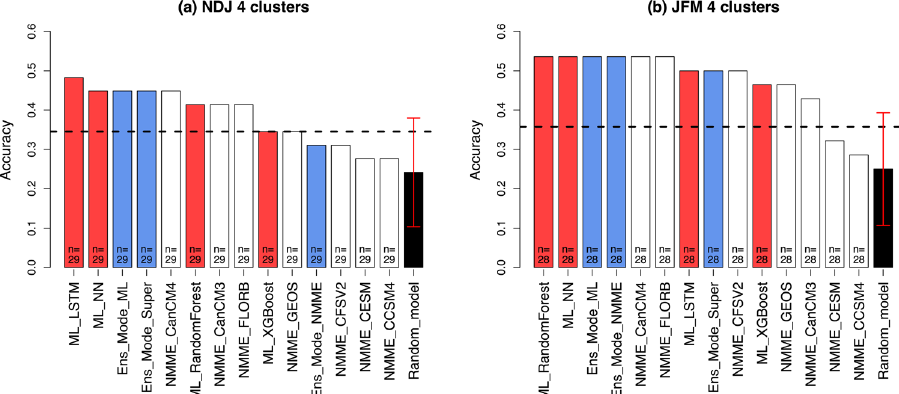
Fig. 2 Accuracy of machine learning models and NMME models. Accuracy of machine learning models (red), NMME models (white), and ensemble models (blue) for NDJ (panel a ) and JFM (panel b ) seasons. Accuracy is de fi ned as the proportion of correct predictions. The sample size (number of predictions made) is given at the base of each bar. Baseline skill is de fi ned here in two ways: (1) the horizontal line de fi ned by the frequency of the most common cluster; (2) a random model prediction repeated 1000 times with bars showing the 5th/95th percentile of the random prediction accuracy. The Ensemble models (blue) are based on the ensemble mode cluster prediction across their respective groups, with Ens_mode_Super based on the ensemble mode across all models. Here accuracy is computed across overlapping years between all models in the test set, refer to Supplementary Material Fig. S11 for accuracy across all